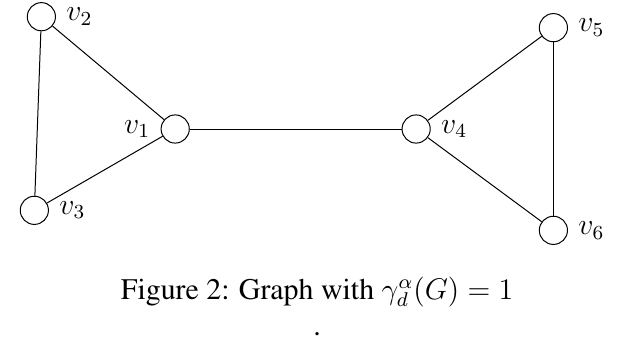
Figure 2: Graph with γ α